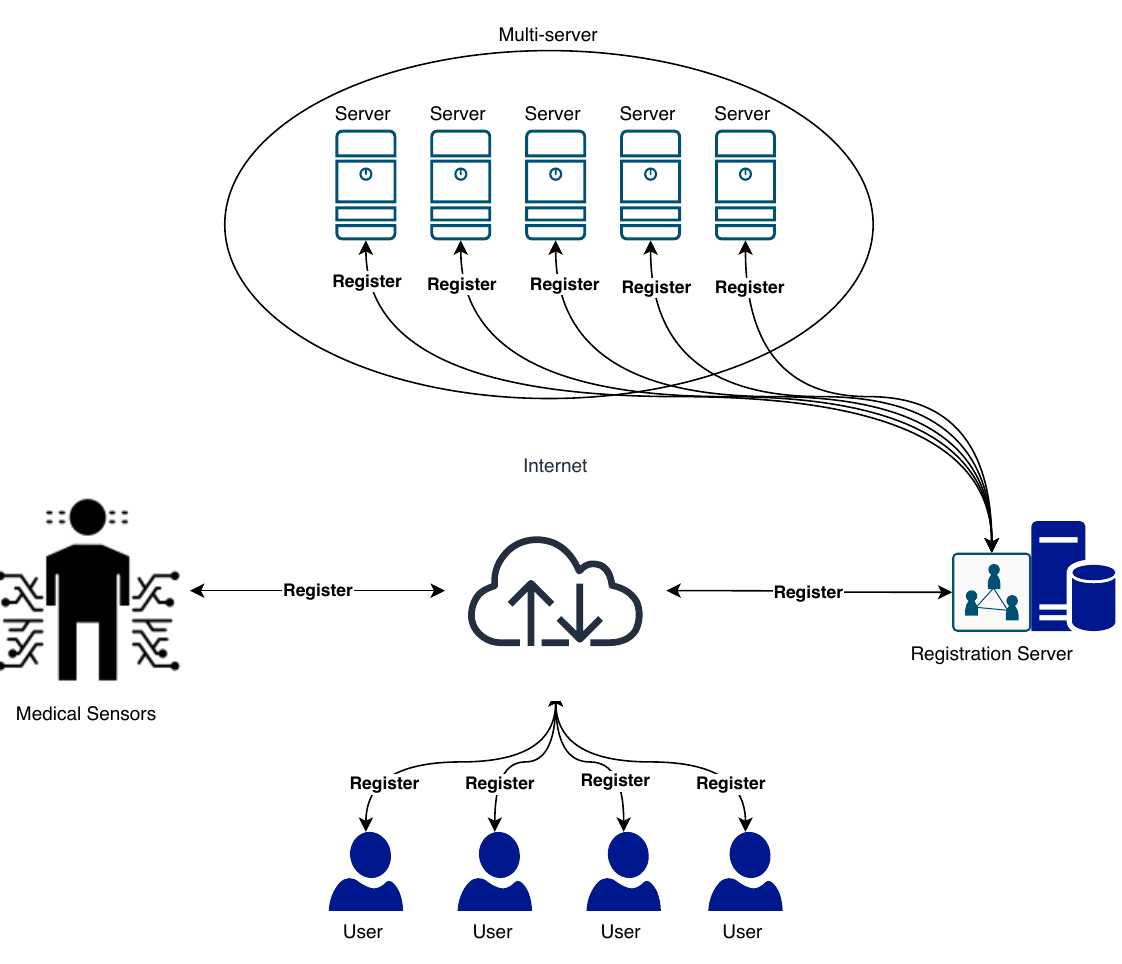
Figure 1. Wireless medical sensor network in multi-server